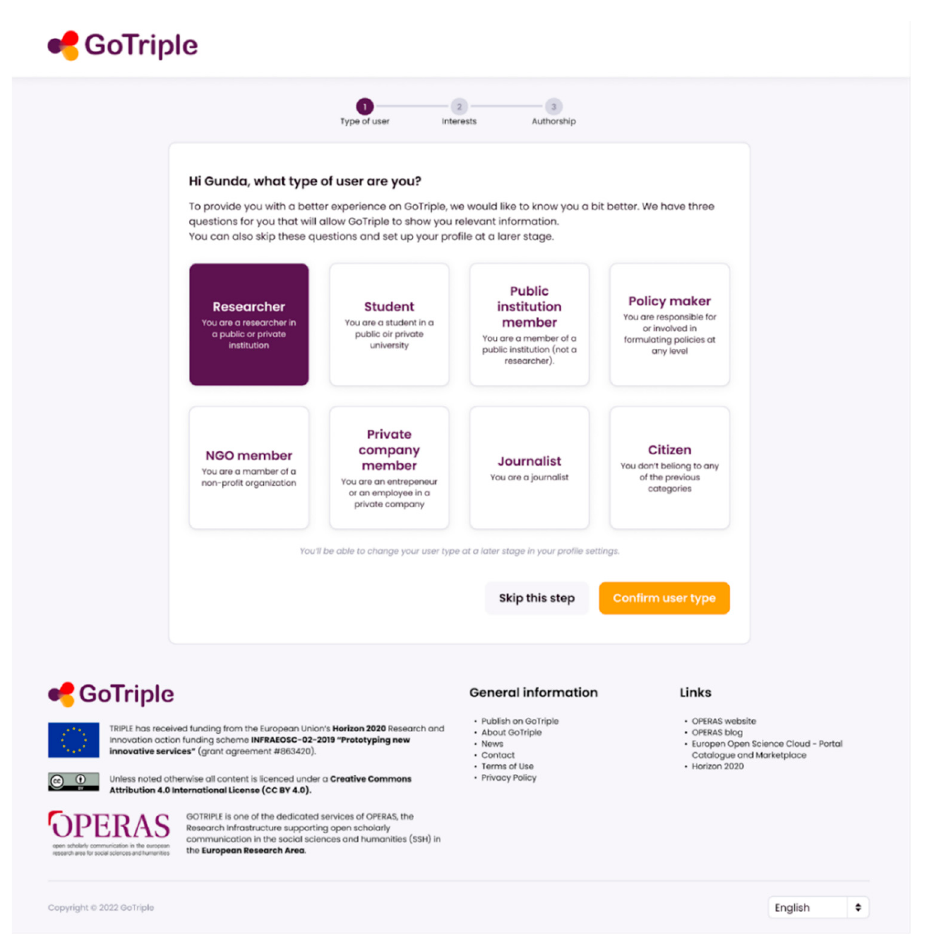
Figure 4. Step of the GoTriple registration process, where users are asked what “type” of user they are (researchers or another type).